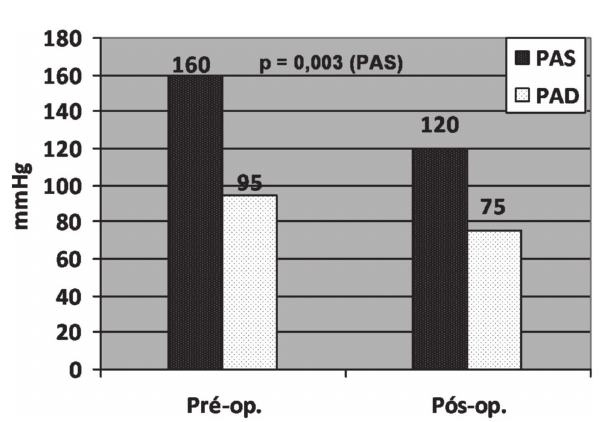
Fig. 5 - Comparação das pressões arterial sistólicas (PAS) e das diastólicas (PAD) médias no pré-operatório e pós-operatório. P = 0,003 (PAS); P = 0,003 (PAD); P <